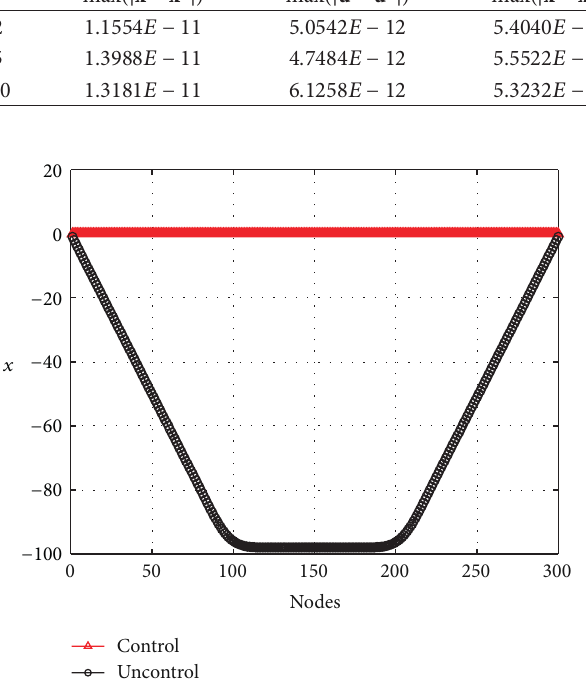
Figure 5: Velocity responses of all masses at 1000sec with and without